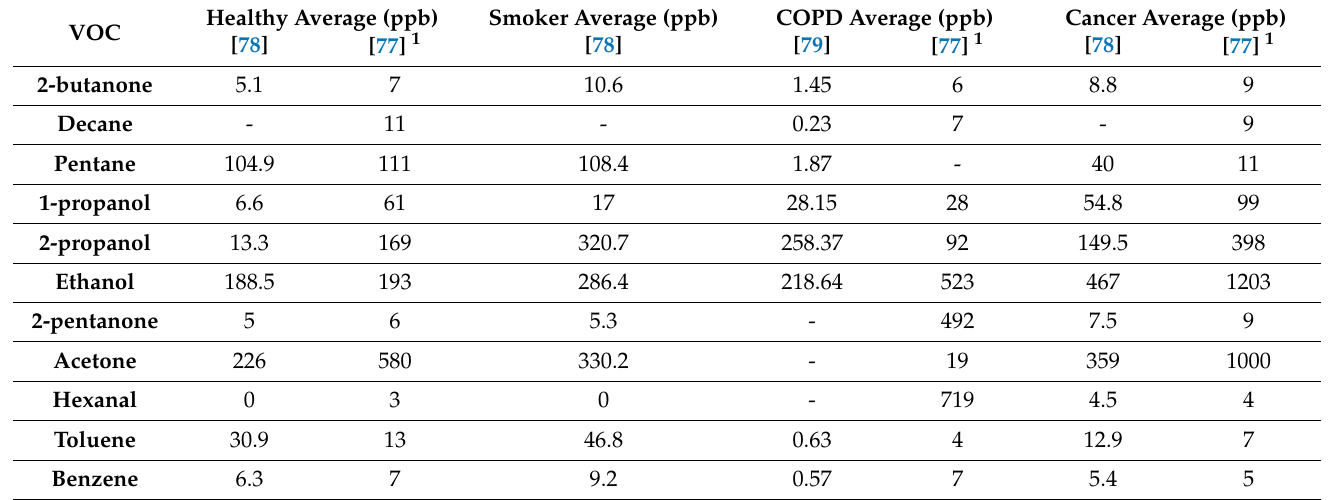
Table 2. Concentrations found in several sources from literature for healthy, lung cancer, COPD and smoker